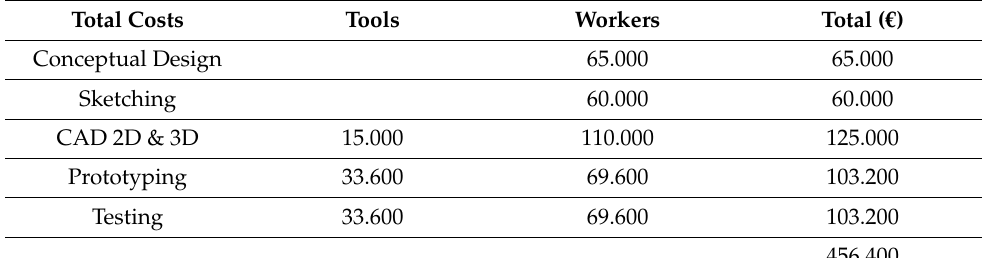
Table 1. Total project